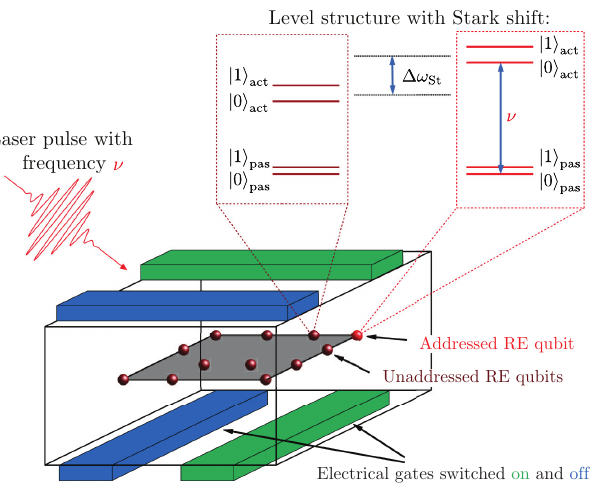
FIG. 9. Sketch of our RE qubit setup with a qubit spacing of order 10 nm. The qubits are activated with laser pulses. A grid of electrical gates, which can be switched on and off, induces a Stark shift on selected qubits. The difference (cid:2)ω St in the Stark shift between neighboring RE ions, which is proportional to the electric field gradient, allows one to address single qubits. Note that the sketch is not true to scale, in particular the thickness of the wires and their distance to the qubits are scaled down to make the figure